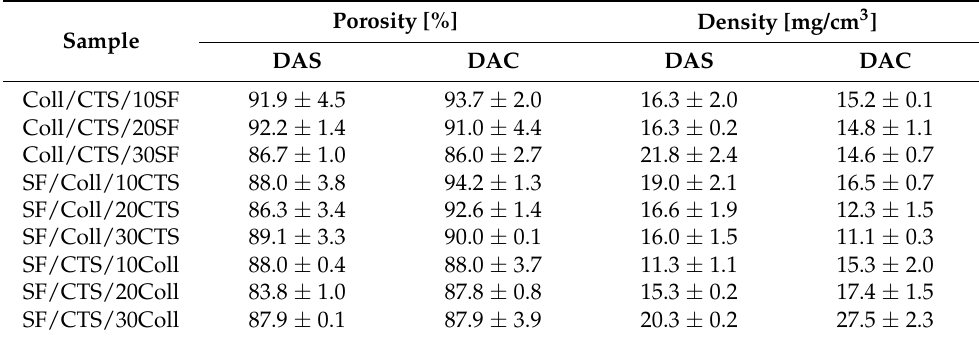
Table 3. Porosity and density of biopolymeric scaffolds cross-linked with dialdehyde starch (DAS) and dialdehyde chitosan (DAC). Results are presented as mean ± standard error of the mean ( n = 3). Porosity [%] Density [mg/cm 3 ] Sample DAS DAC DAS DAC Coll/CTS/10SF 91.9 ± 4.5 93.7 ± 2.0 16.3 ± 2.0 15.2 ± 0.1 Coll/CTS/20SF 92.2 ± 1.4 91.0 ± 4.4 16.3 ± 0.2 14.8 ± 1.1 Coll/CTS/30SF 86.7 ± 1.0 86.0 ± 2.7 21.8 ± 2.4 14.6 ± 0.7 SF/Coll/10CTS 88.0 ± 3.8 94.2 ± 1.3 19.0 ± 2.1 16.5 ± 0.7 SF/Coll/20CTS 86.3 ± 3.4 92.6 ± 1.4 16.6 ± 1.9 12.3 ± 1.5 SF/Coll/30CTS 89.1 ± 3.3 90.0 ± 0.1 16.0 ± 1.5 11.1 ± 0.3 SF/CTS/10Coll 88.0 ± 0.4 88.0 ± 3.7 11.3 ± 1.1 15.3 ± 2.0 SF/CTS/20Coll 83.8 ± 1.0 87.8 ± 0.8 15.3 ± 0.2 17.4 ± 1.5 SF/CTS/30Coll 87.9 ± 0.1 87.9 ± 3.9 20.3 ± 0.2 27.5 ±